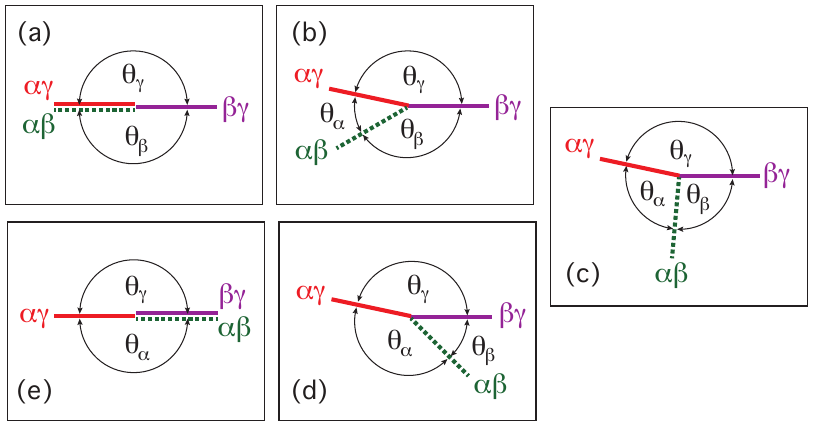
Figure 9. Apparent contact angles θ α , θ β , and θ γ for the adhesion morphologies in Figure 2: ( a ) Complete wetting by the α phase, which is equivalent to complete dewetting from the β phase, corresponds to the limit θ α = 0 and θ β = θ γ = π ; ( b ) Partial dewetting from the β phase with θ α < θ β ; ( c ) Balanced adhesion with θ β = θ α ; ( d ) Partial wetting by the β phase with θ β < θ α ; and ( e ) Complete wetting by the β phase, which is equivalent to complete dewetting from the α phase, corresponds to the limit θ β = 0 and θ α = θ γ = π